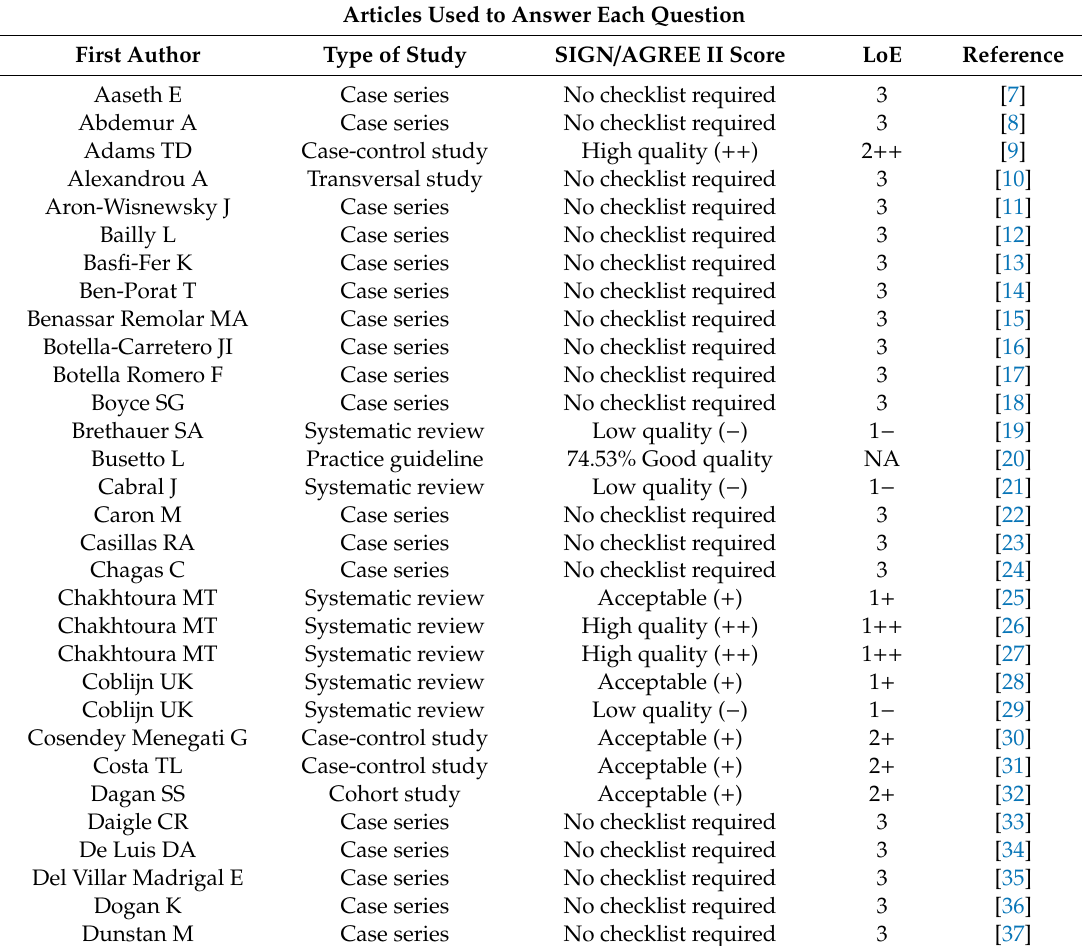
Table 3. List of study articles / guidelines used to respond to the 20 selected